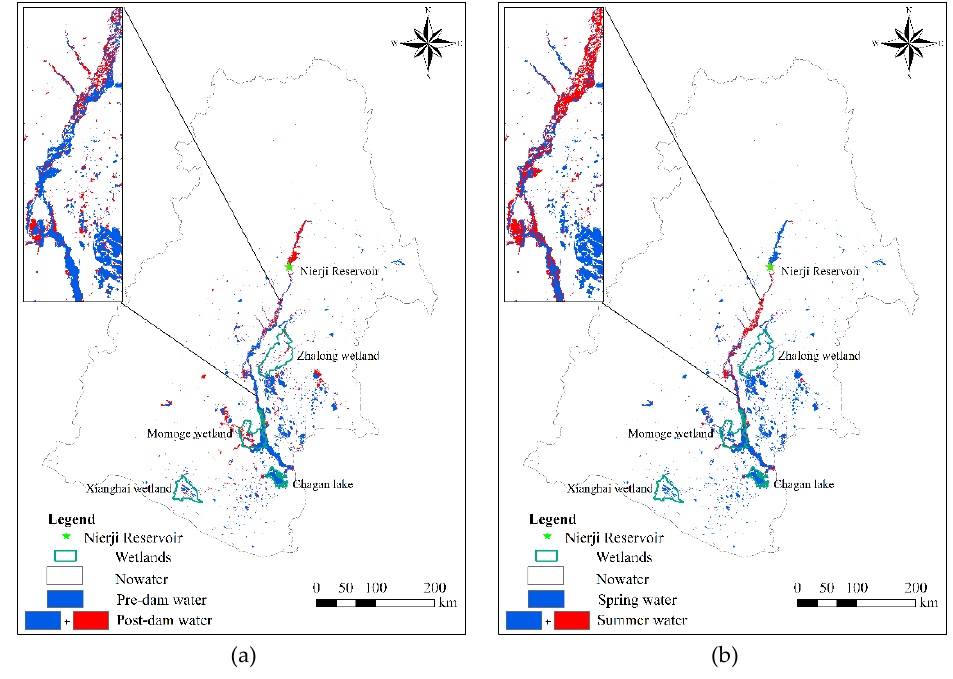
Figure 4. Distribution of open waterbody surface in the Nenjiang River Basin, Northeast China, during ( a ) pre-dam 2000–2004 and post-dam 2006–2018 periods and ( b ) in the spring and